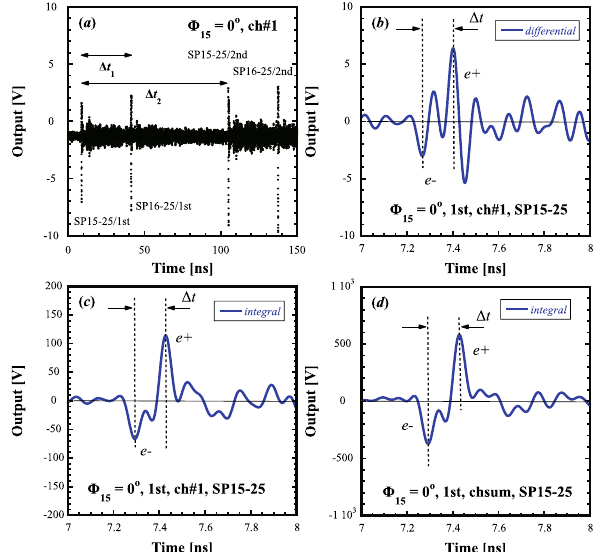
Figure 1. Typical detected pickup signals in the nominal e + -production operation. ( a ) Corrected signal in the time span of 150 ns, ( b ) differential signal in the time span of 1 ns, ( c ) its integrated signal, ( d ) its integrated four-channel-sum signal. The detected signals in ( a ), ( b ), and ( c ) are from ch#1 of SP15-25 and that in ( d ) is from the four-channel sum at (cid:31) 15 = 0 o